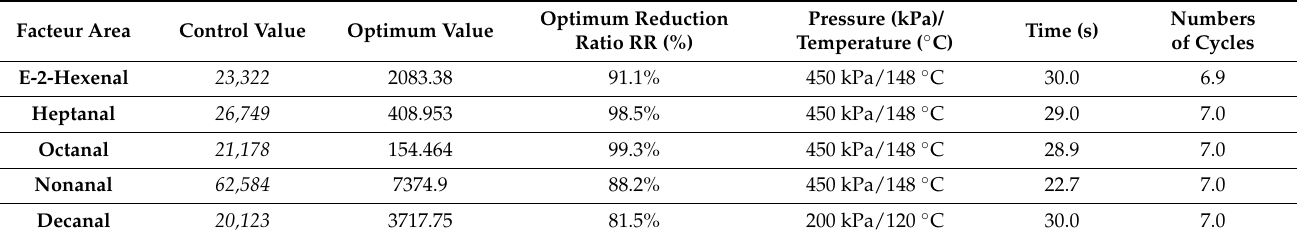
Table 6. Optimization of MFA processing